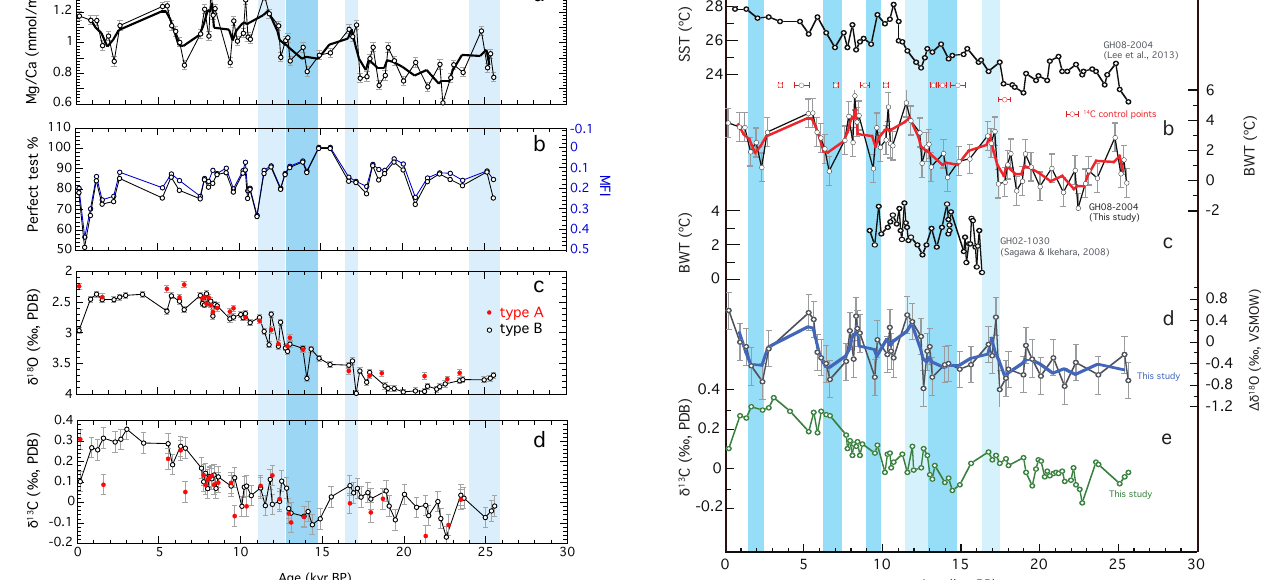
Figure 9. (a) Sea surface temperature (SST) derived from Mg / Ca of the planktic foraminifera G. ruber of core GH08-2004 (Lee et al., 2013), (b) bottom water temperature (BWT) of core GH08- 2004 (this study), (c) Mg / Ca-derived BWT of U. akitaensis of core GH02-1030, 1212m water depth in the subarctic western North Pa- cific (Sagawa and Ikehara, 2008), and (d) local δ 18 O w ( (cid:49)δ 18 O w ) and (e) benthic δ 13 C of GH08-2004 (this study). Bold lines indi- cate three-point running mean in (b) and (d) . The ± 1 ◦ C errors and propagated errors are expressed as error bars in (b) and (d)